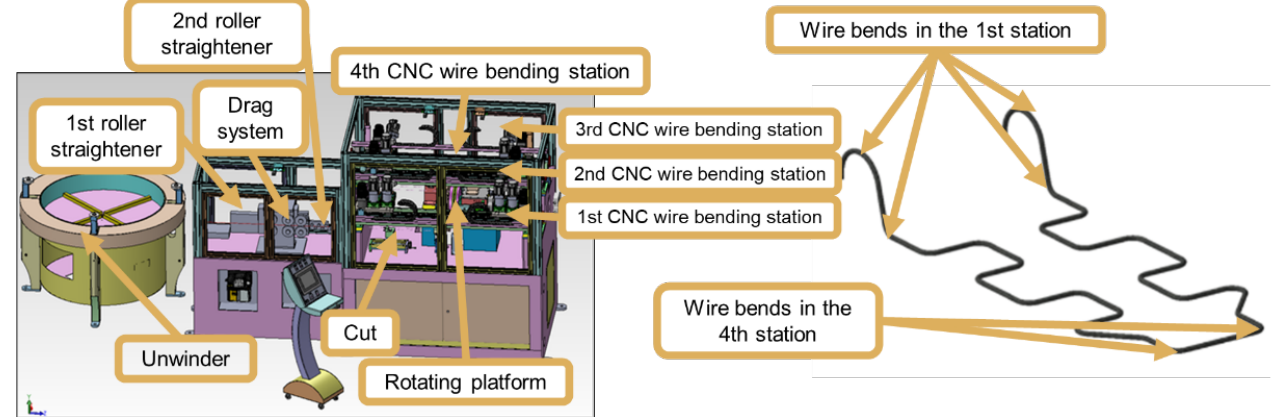
Figure 5. Specific wire-bending machine (U-shaped wires).